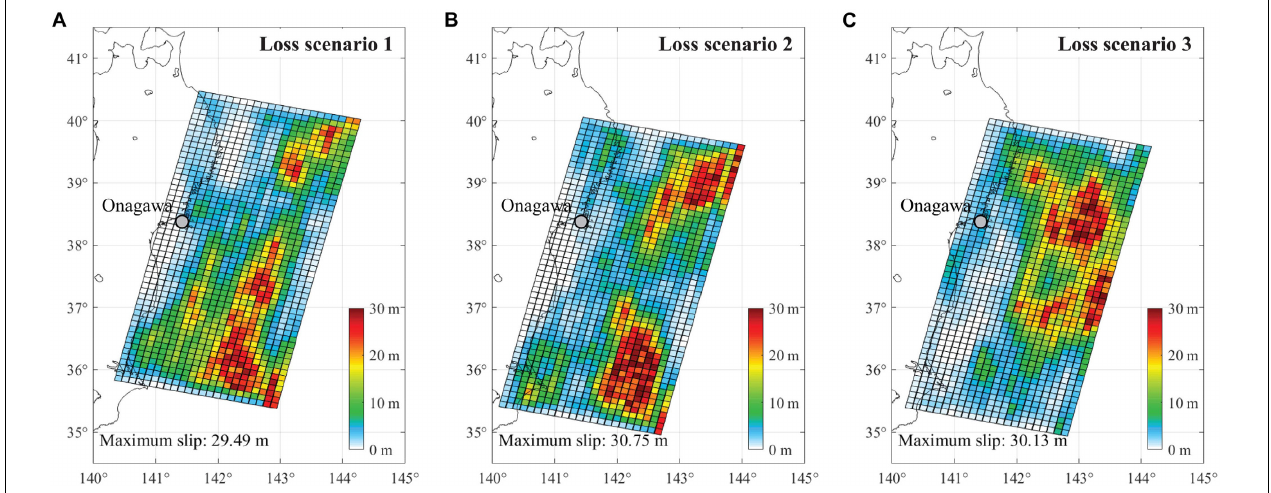
FIGURE 10 | Earthquake slip models of M w 9.0 events corresponding to three loss scenarios identified for Onagawa: (A) loss scenario 1 (10th percentile of total loss), (B) loss scenario 2 (50th percentile of total loss), and (C) loss scenario 3 (90th percentile of total